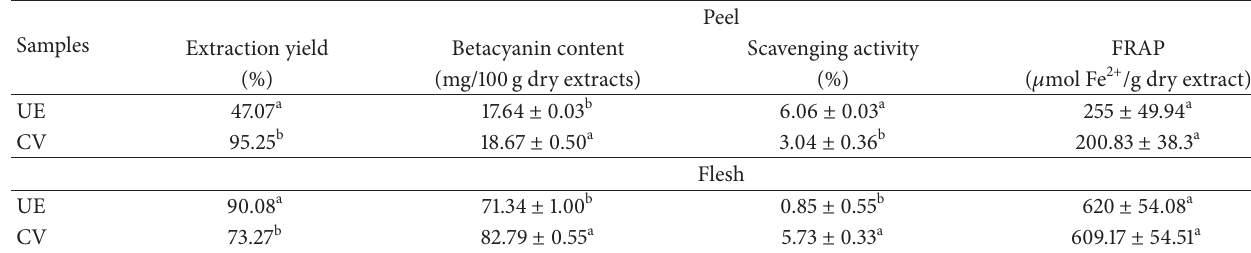
Table 1: Extraction yield, betacyanin content, scavenging activity, and reducing power of peel and flesh from red pitaya of different extraction methods.